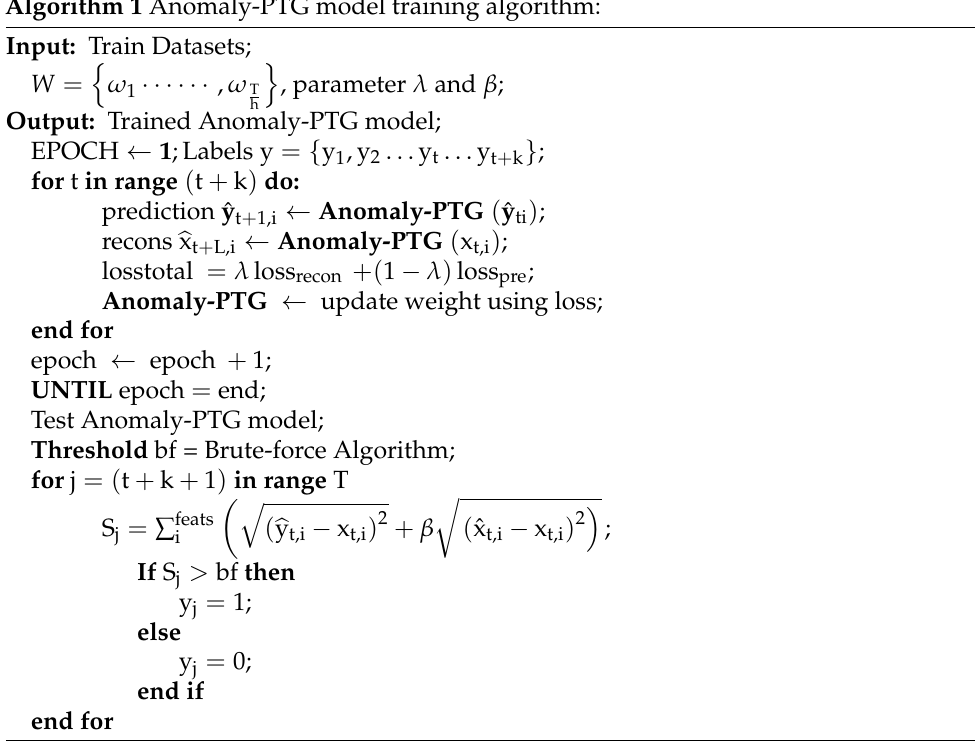
Algorithm 1 Anomaly-PTG model training